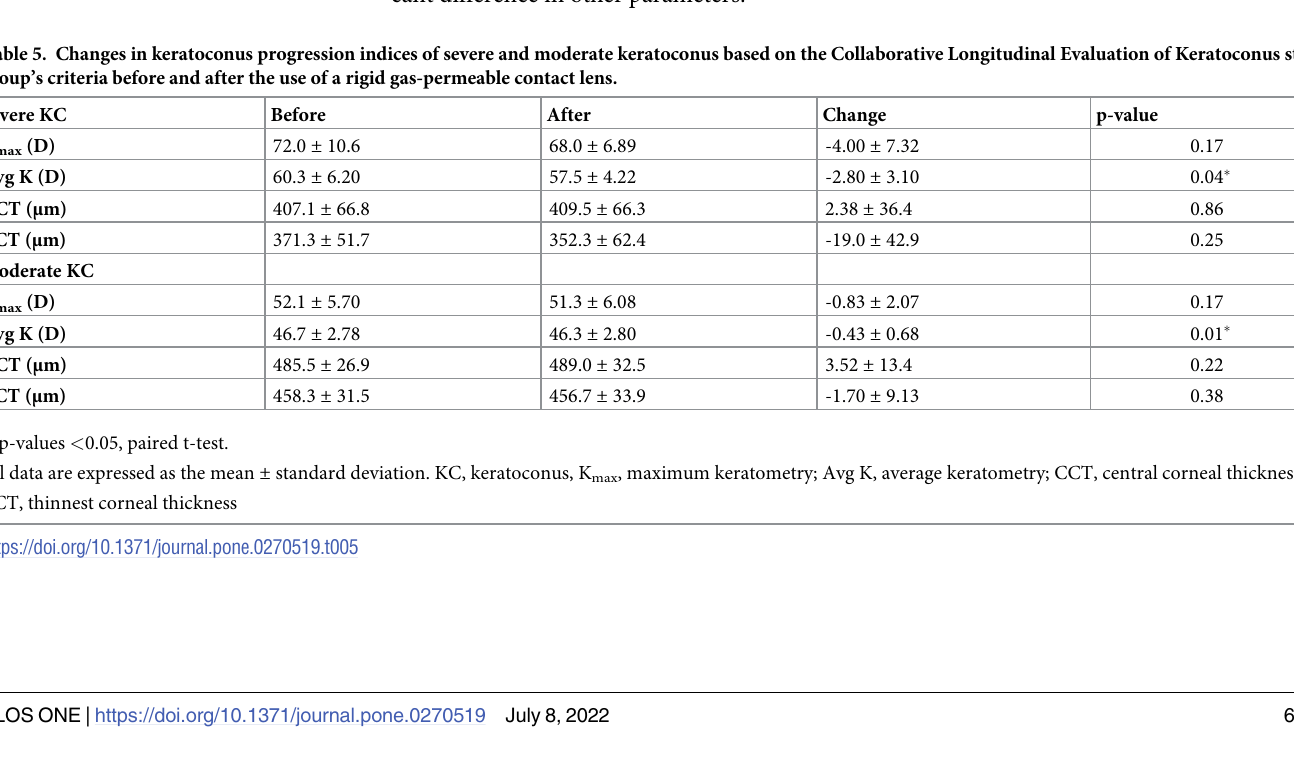
Comparison of changes in corneal indices based on the severity of KC There was a significant decrease in the Avg K values after RGP lens use in both the severe and moderate KC groups, according to the Amsler–Krumeich classification (Table 4) and CLEK criteria (Table 5). In intragroup comparisons, the severe KC group showed a significantly greater change in Avg K values than the moderate KC group, according to both the Amsler– Krumeich classification (p = 0.02) and CLEK criteria (p = 0.014) (Fig 2). There was no signifi- cant difference in other parameters. Table 5. Changes in keratoconus progression indices of severe and moderate keratoconus based on the Collaborative Longitudinal Evaluation of Keratoconus study group’s criteria before and after the use of a rigid gas-permeable contact lens. Severe KC Before After Change p-value